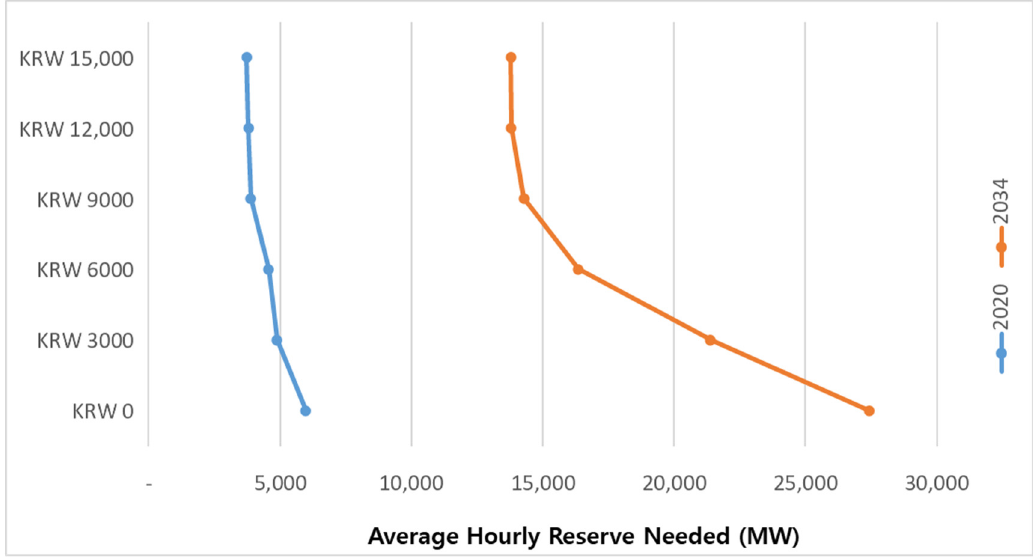
Figure 7. Operating reserve demand curves in 2020 and 2034.